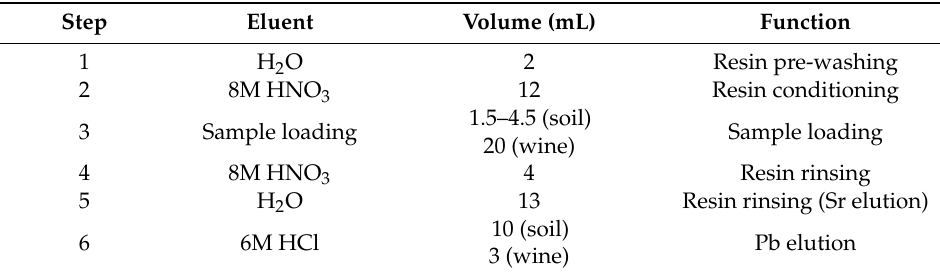
Table 1. Separation scheme for Pb